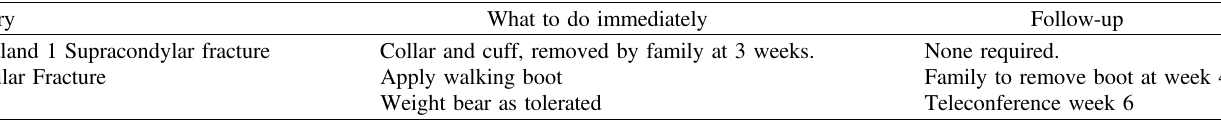
Table 2. Examples for Recommendations for Orthopedic Pediatric Trauma Management during COVID-19 pandemic [37]. Injury Gartland 1 Supracondylar fracture Collar and cuff, removed by family at 3 weeks.